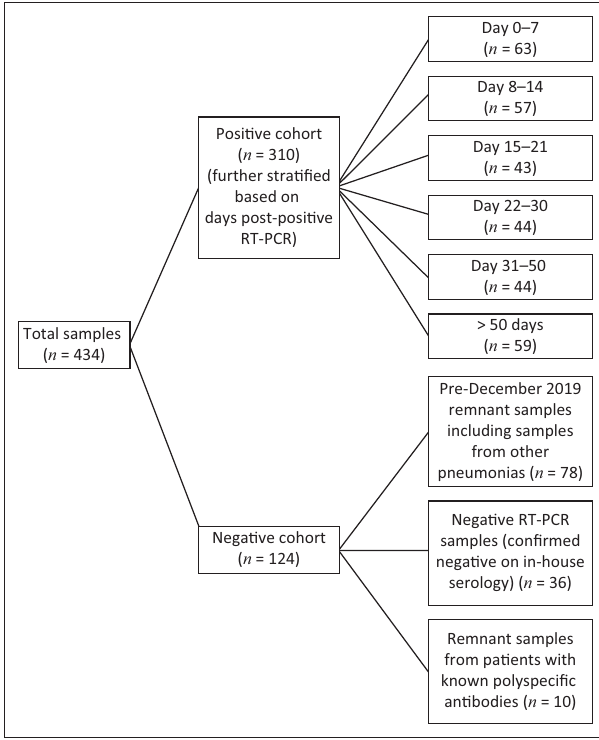
FIGURE 1: Summary of samples used in